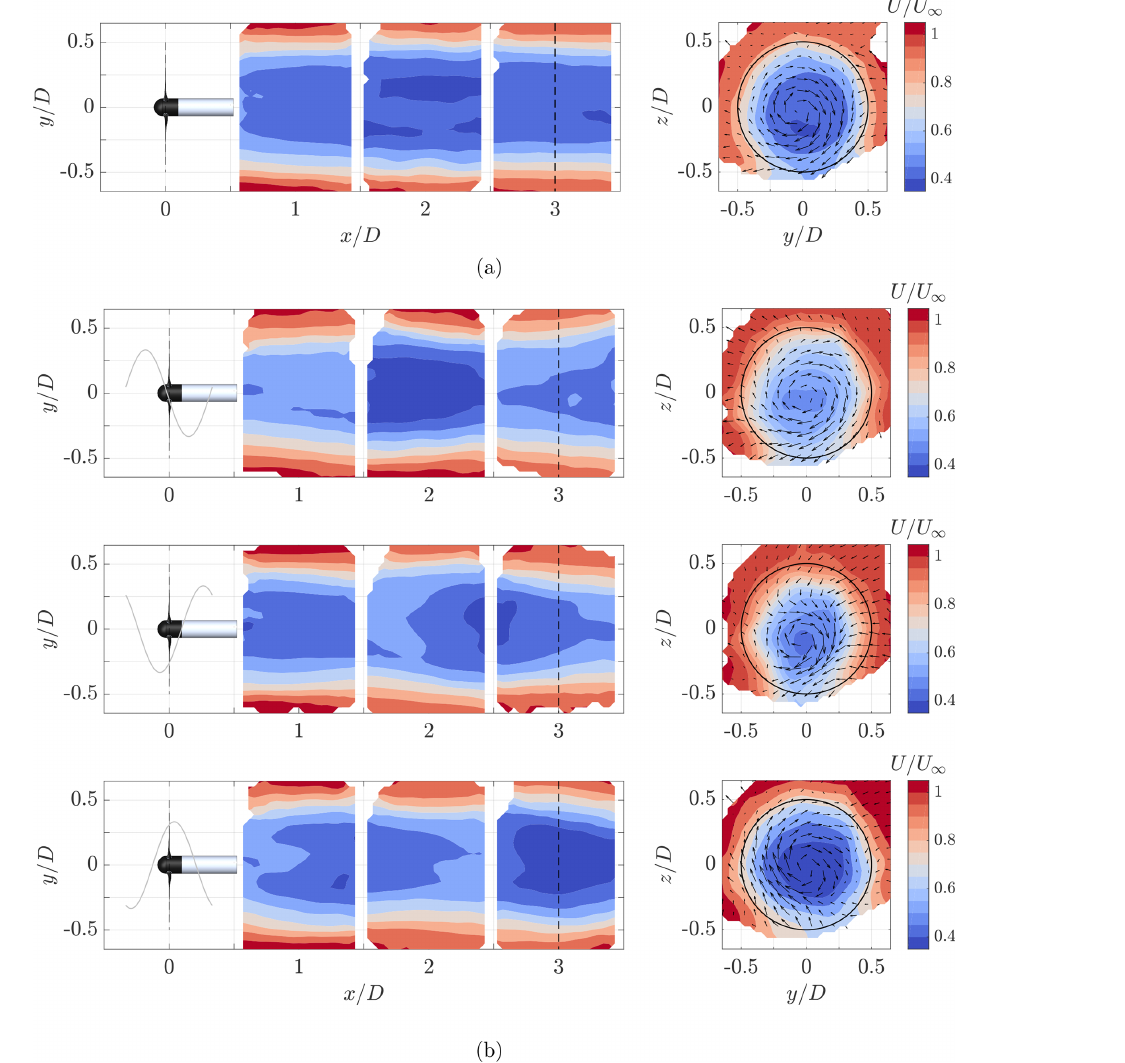
Figure 9. Cross-section of the periodically averaged wake at hub height ( z/D = 0) and at three diameters downstream of a turbine operating with (a) baseline control and (b) DIC ( St = 0 . 24). The contours show the normalized streamwise velocity components, and the arrows indicate the cross-stream velocity components. The gray line indicates the pitch angle at different phases of the pitch